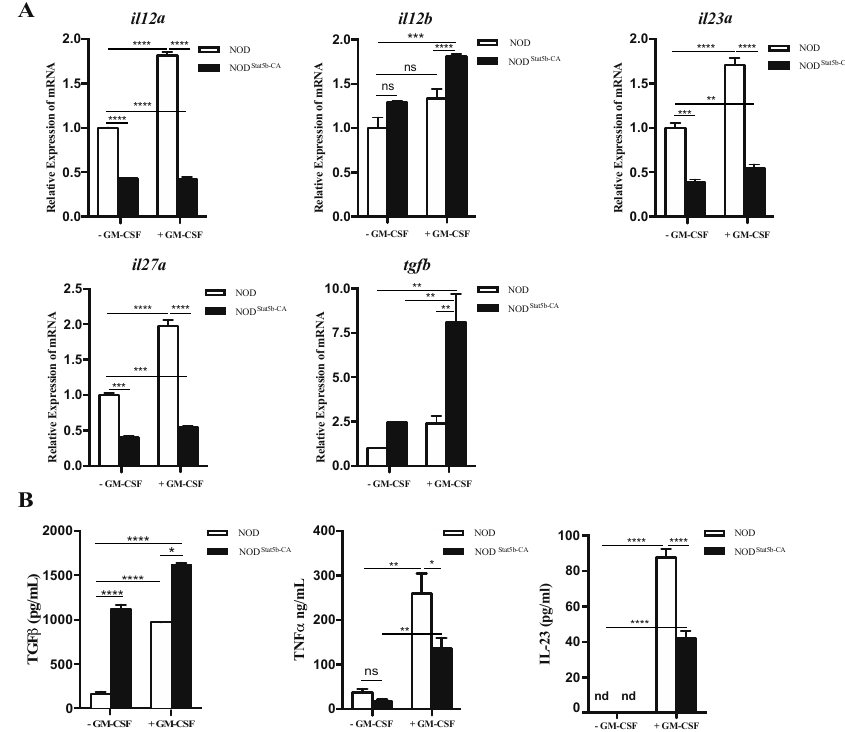
Figure 2. Cytokine profiles of BMDCs derived from NOD and NOD.CD11c Stat5b-CA mice. BMDCs (1 × 10 5 cells / well) generated from NOD and NOD.CD11c Stat5b-CA mice were cultured for 48 h in the absence or presence of GM-CSF (50 ng / mL). ( A ) Relative expression of Il12a , Il12b , Il23a , Il27a , and Tgf β genes was determined by qPCR using the ∆∆ CT method. qPCR data are shown as relative expression compared to untreated BMDCs of NOD mice. ( B ) Quantification of TGF β , TNF α , and IL-23 released in the supernatants of BMDCs exposed or not to GM-CSF as determined by ELISA. Data are shown as the mean ± SEM of at least three independent experiments. The asterisks indicate statistically significant di ff erences determined using one-way ANOVa with Tukey’s post-test. p < 0.05 (*), p < 0.01 (**), p < 0.001 (***), and p < 0.0001 (****). nd: not